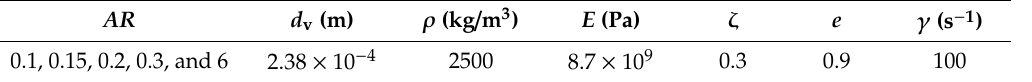
Figure 2. Numerical model of shear flow of a binary mixture of rods and disks. Table 1. Particle properties and simulation parameters.